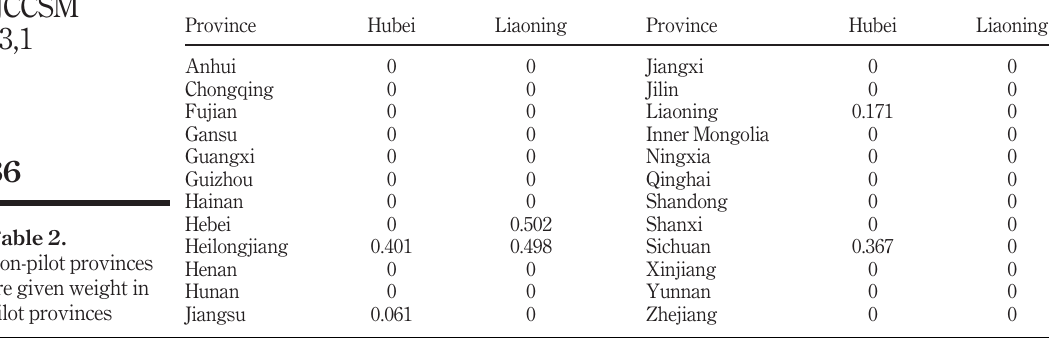
Table 2. Non-pilot provinces are given weight in pilot